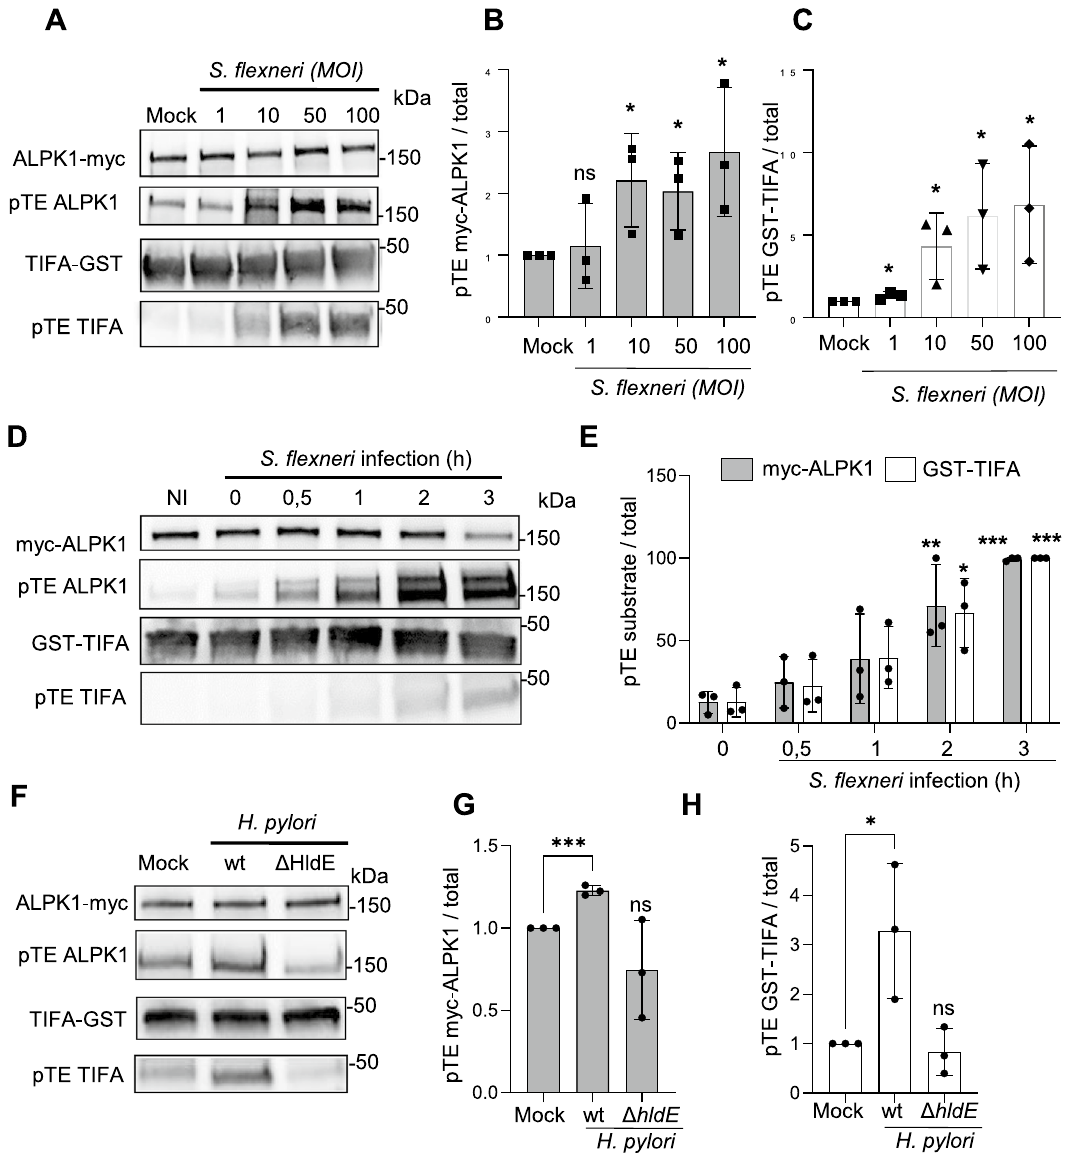
Figure 3. S. flexneri and H. pylori infections induce the phosphorylation of ALPK1 and TIFA. ( A ) ALPK1 activity is enhanced in response to increasing S. flexneri MOIs. HEK293 cells, transfected with a myc-hALPK1 cDNA construct, were infected or not with wt S. flexneri at indicated MOIs for 1 h. ALPK1 kinase activity was then assessed by the newly described protein thiophosphorylation assay. ( B ) Quantification of myc-ALPK1 thiophosphorylation. ( C ) Quantification of GST-TIFA thiophosphorylation. ( D ) ALPK1 activity is sustainably enhanced during S. flexneri infection. HEK293 cells, transfected with a myc-hALPK1 cDNA construct, were infected or not with wt S. flexneri for indicated time-periods at MOI 10. ALPK1 kinase activity was then assessed by the newly described protein thiophosphorylation assay. ( E ) Quantification of myc-ALPK1 and GST-TIFA thiophosphorylation. ( F ) ALPK1 activity is increased during H. pylori infection of cells in an ADPH-dependent manner. HEK 293T cells transfected with a myc-hALPK1 cDNA construct, were infected or not with wt or an Δ hldE H. pylori mutant at MOI 20 for 4 h. ALPK1 kinase activity was then assessed by the newly described protein thiophosphorylation assay. ( G ) Quantification of myc-ALPK1 thiophosphorylation as shown in ( F ). ( H ) Quantification of GST-TIFA thiophosphorylation as shown in ( F ). All data correspond to the mean ± SD of 3 independent experiments. Statistical significance was assessed between mock and each condition individually using unpaired t test ( B , C , G , H ) or using two ‐ way ANOVA (E) followed by Tukey’s multiple comparisons test, * P < 0.05, ** P < 0.01, *** P <